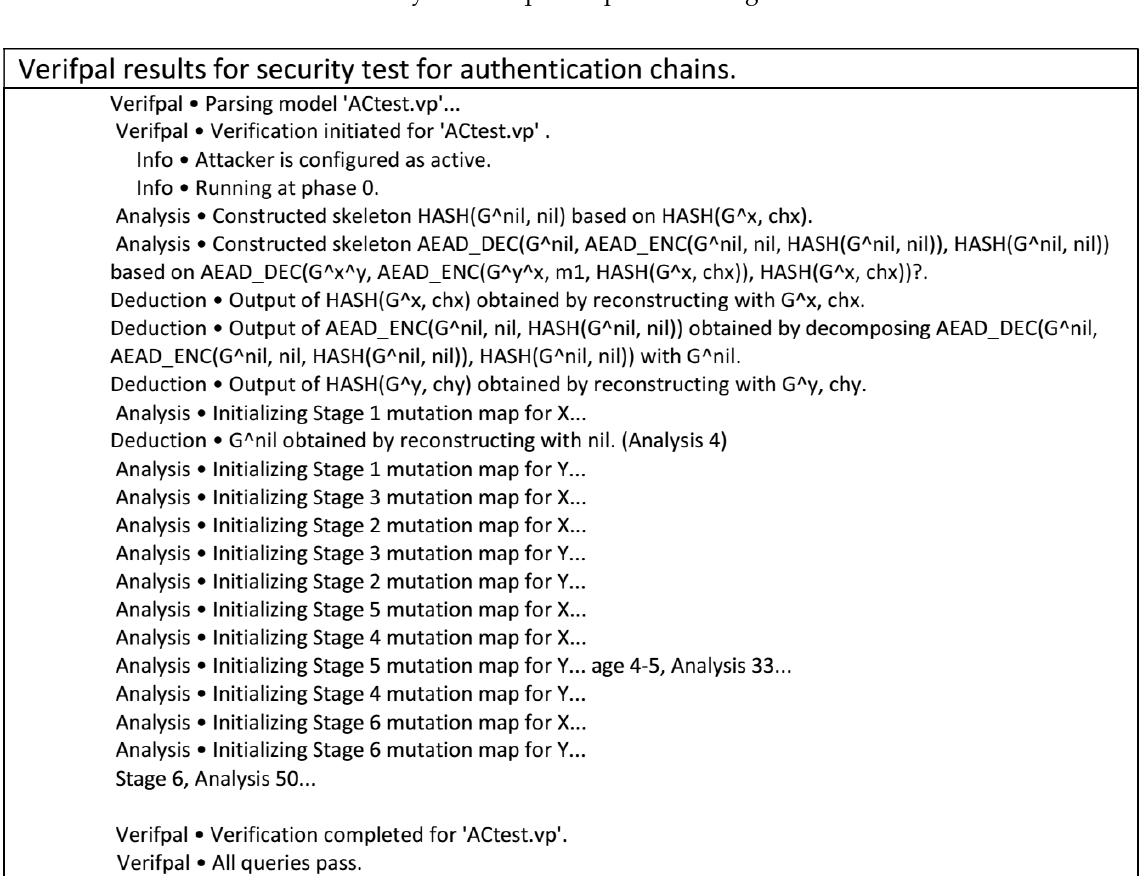
Figure 10. Verifpal security analysis results.